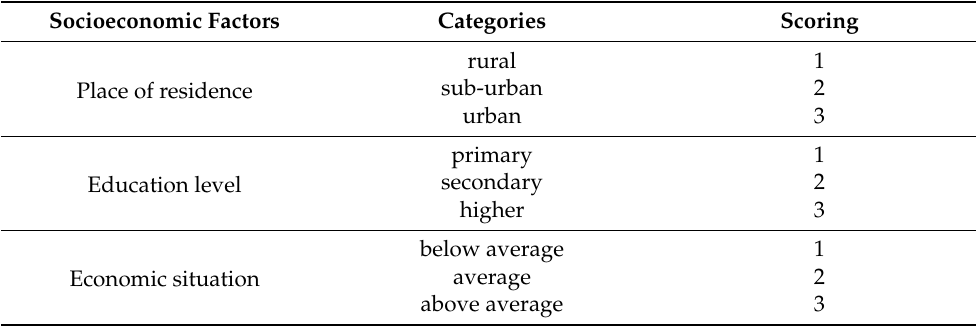
Table 1. Description of the socioeconomic status factors scoring—values assigned to the response categories.